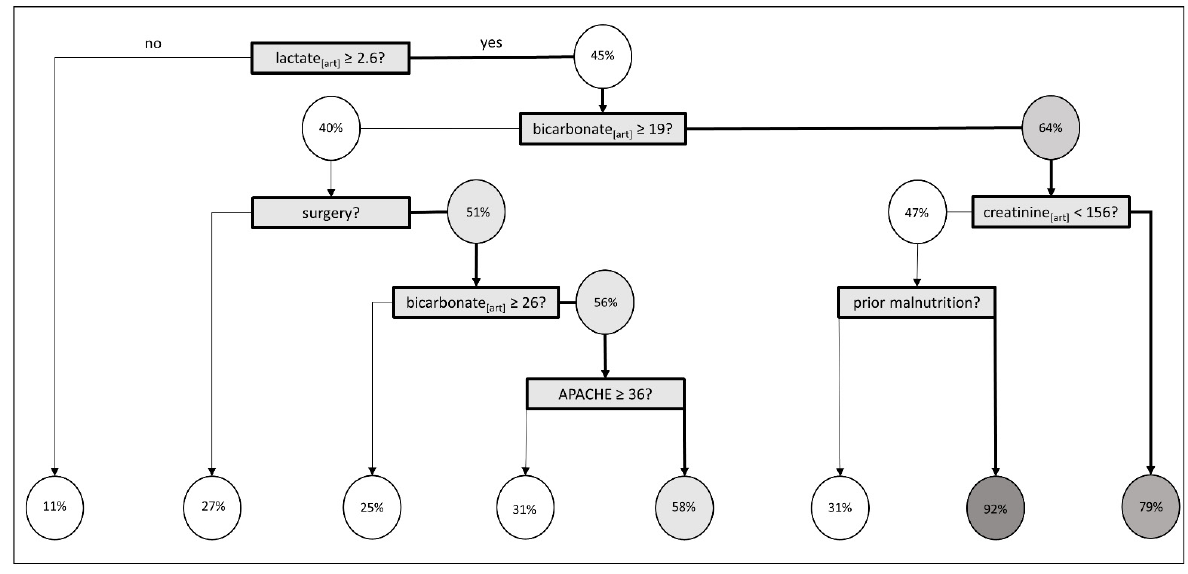
Figure 3. Classification Decision Tree. Percentages indicate the proportion of patients with fluid overload (FO). The darker the grey, the higher the percentage of patients developing a FO. Acute Physiology and Chronic Health Evaluation (APACHE) IV. Lactate and bicarbonate were measured in arterial blood samples [art].